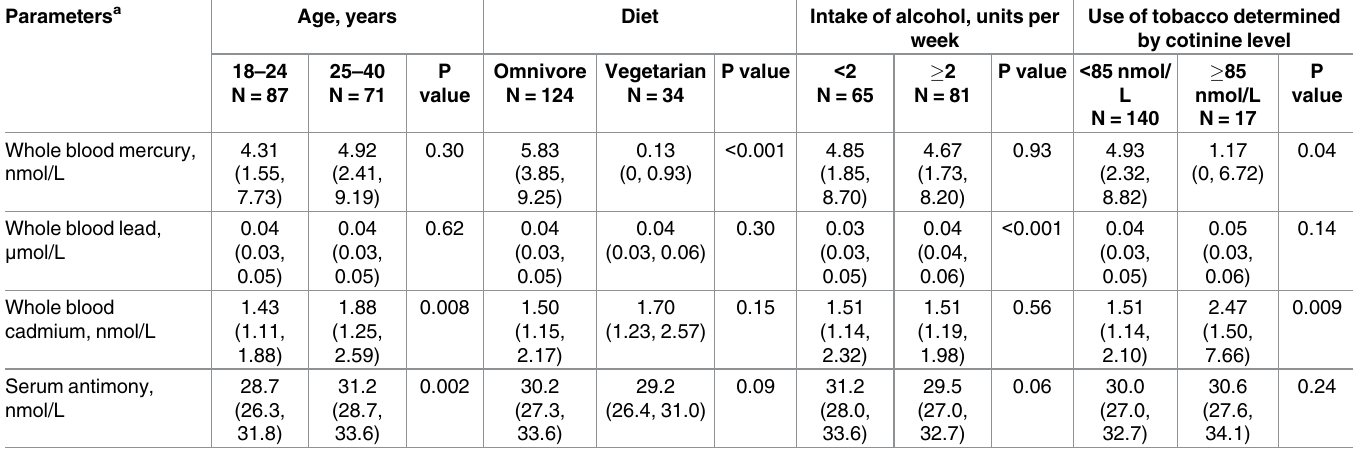
(cid:21) 25 years, when compared by Mann-Whitney to the younger age-group (Table 2). Age remained a significant predictor for Hg and Sb in a multiple linear regression model, which additionally included type of diet, fish intake, alcohol intake, use of tobacco, education, BMI and use of omega 3/cod oil supplements (Table 3). Vegetarians had lower levels of Hg and Sb compared to omnivores (Table 2), and this was evident also in the multiple linear regression model (Table 3). No differences in levels of toxic trace elements were seen between vegans and vegetarians (p > 0.22, data not shown). Fish intake was the strongest predictor for Hg in the multiple linear regression model (Table 3). Median whole blood Hg was increased by a factor of 70 in women who had fish for dinner (cid:21) 1/week, compared to women who rarely or never ate fish (Table 4). Table 2. Levels of toxic trace elements according to age, diet, intake of alcohol and use of tobacco in healthy never-pregnant women (n = 158). Parameters a